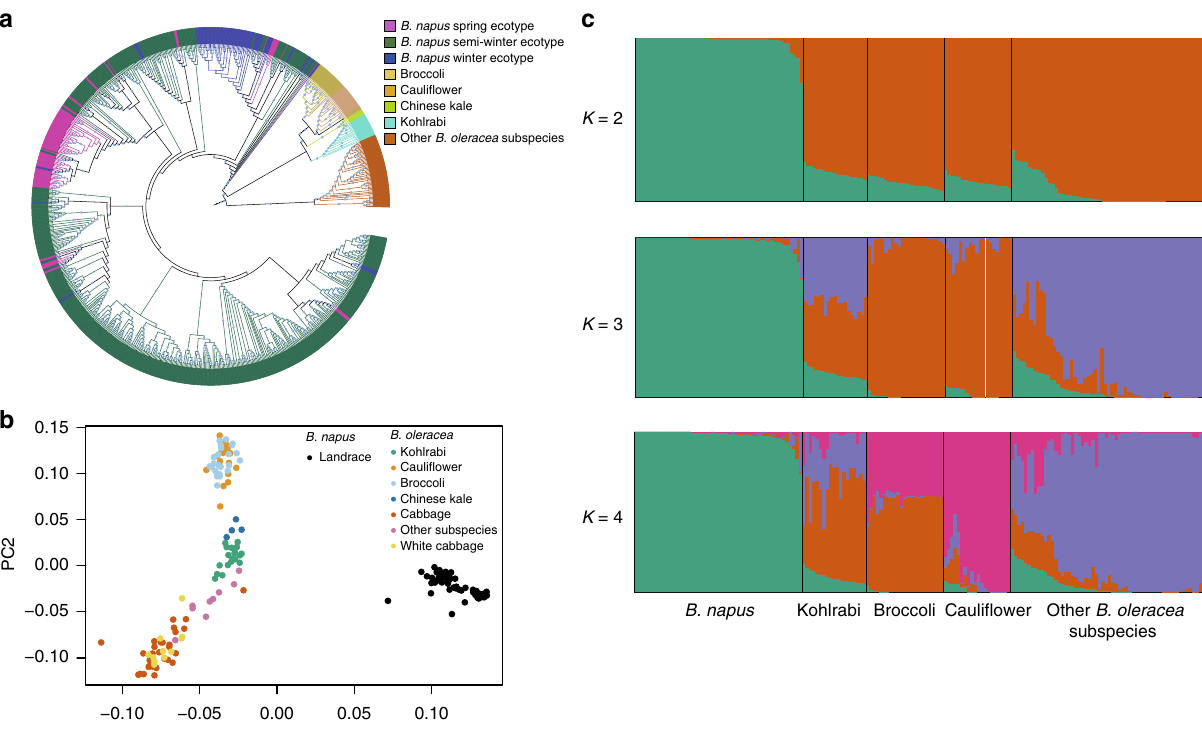
Fig. 3 Population structure of 588 B. napus accessions and 119 of B. oleracea accessions. a ML tree of all B. napus accessions and 119 B. oleracea accessions inferred from SNPs at fourfold-degenerate sites. Phylogenetic tree was constructed using IQ-TREE with the best model TVM + F + ASC + R8. Clades with bootstrap values of above 50% are indicated by a circled blue dot. b PCA plot of 50 B. napus landraces and 119 B. oleracea accessions. c Model-based Bayesian clustering of 50 B. napus landraces and 119 B. oleracea accessions performed using STRUCTURE 2.1 with the number of ancestry kinships ( K ) set to 2, 3, or 4. Each accession is denoted by a vertical bar composed of different colors in proportions corresponding to its proportion of genetic ancestry from each of these ancestral populations. Source data are provided as a Source Data fi